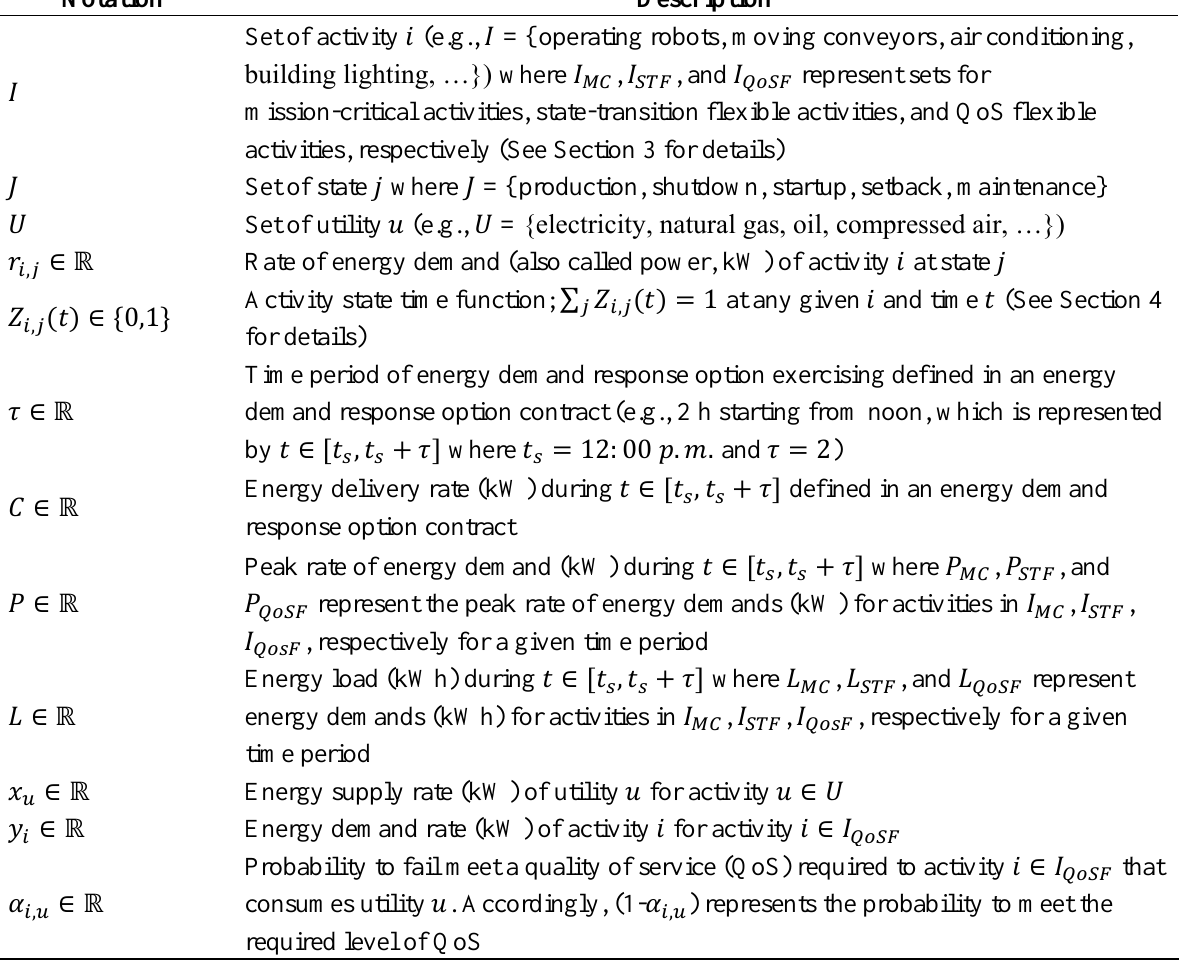
Table 1. Summary of